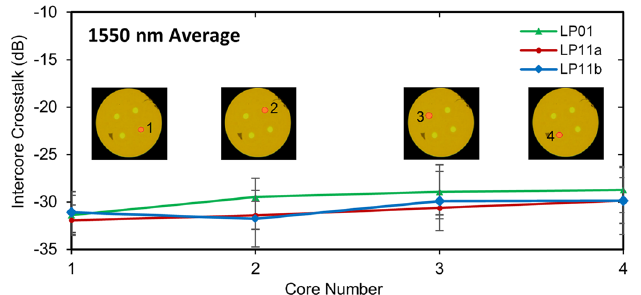
Figure 6. Intercore crosstalk. The intercore crosstalk at the end of the 4-core fiber, when exciting the modes with the FM-MCF spatial multiplexer at 1550 nm. The intercore crosstalk when exciting a given LP lm mode in a given core, is calculated from the average crosstalk between the given core and each of other